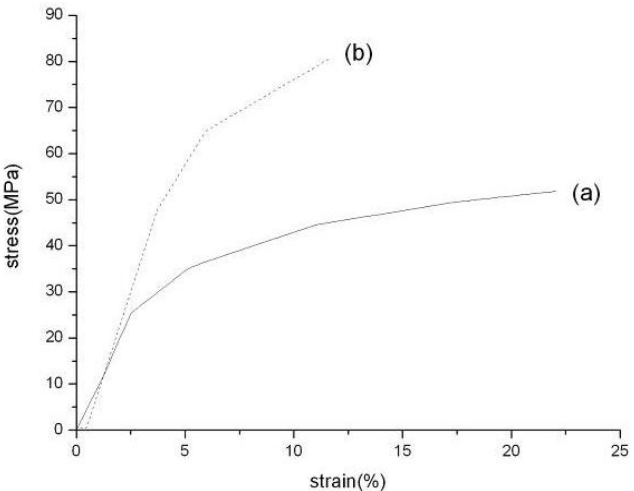
Figure 5. Stress-strain curves of PAN nanofiber sheets before and after hot-stretched: (a) as-spun; (b)